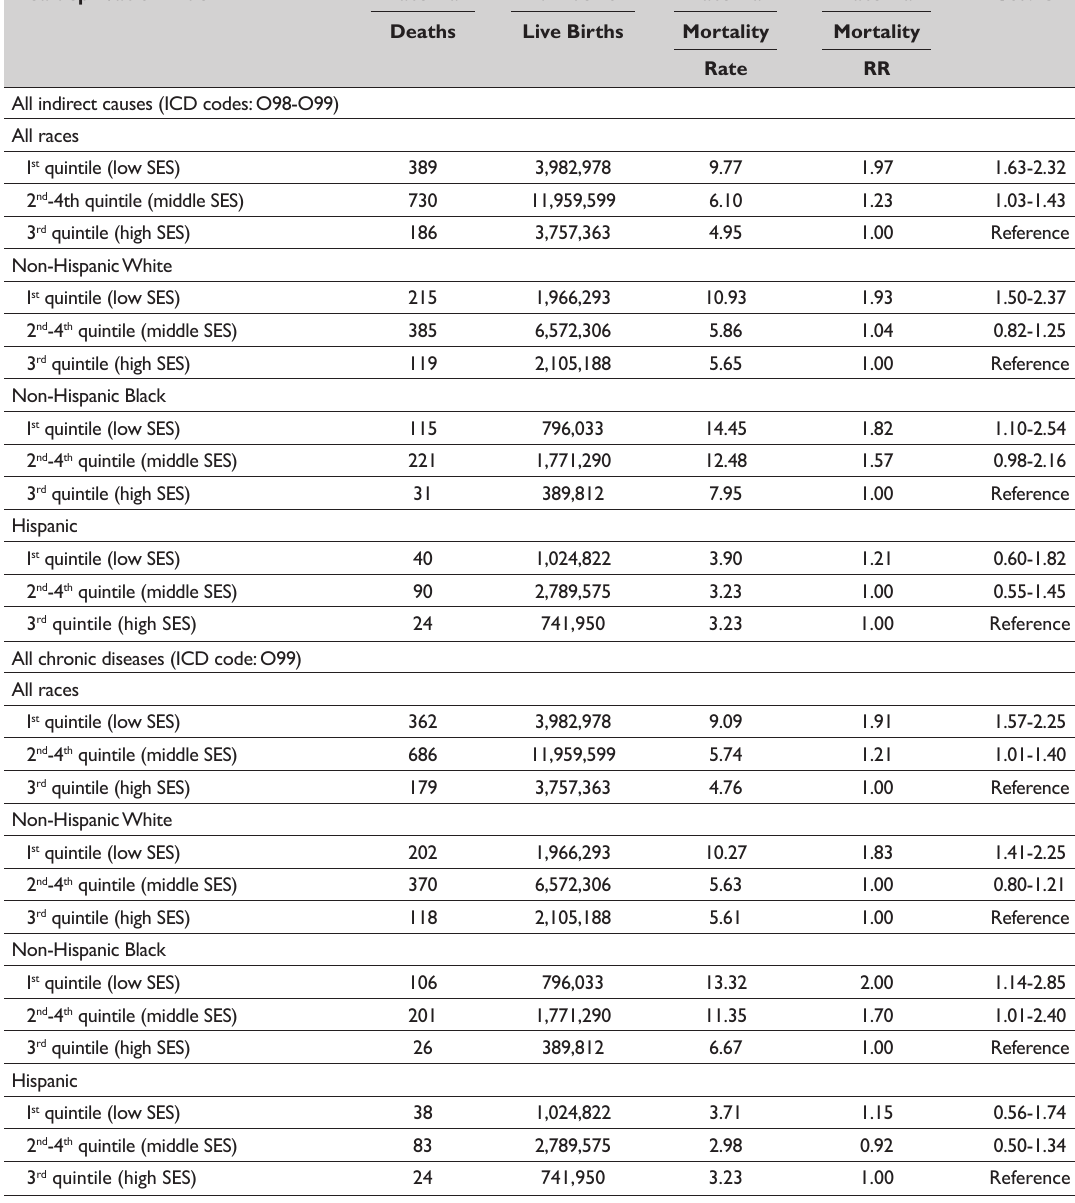
Table 3: Maternal deaths and mortality rates per 100,000 live births due to indirect obstetric causes (ICD-10 codes: O98-O99) by Area Deprivation Index, United States, 2013-2017 (number of live births